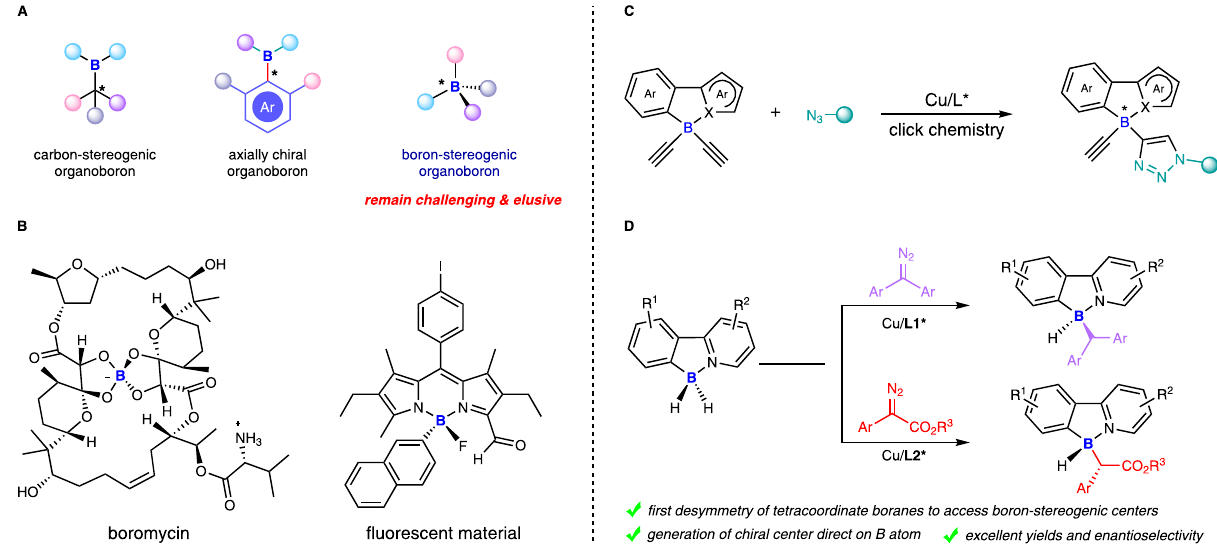
Fig. 1 Boron-stereogenic compounds and their catalytic enantioselective synthesis. A Current status of chiral organoboron chemistry. B Boron- stereogenic compounds in nature product and material. C Asymmetric CuAAC for the synthesis of boron-stereogenic compounds (He et al.). D Catalytic desymmetric B-H insertion toward boron-stereogenic compounds (this